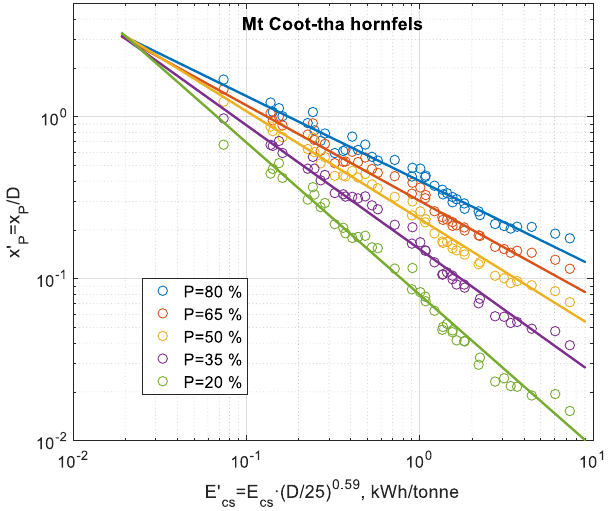
Figure 2. Normalized percentile fragment sizes vs. scaled impact energy data from DWT, showing fragmentation-energy fan behavior (Figure 4 in [21]).